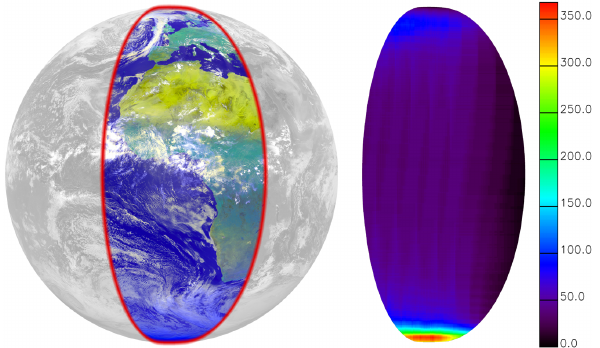
Fig. 6. Selected region for comparison between cirrus products (left panel). Numbers of synchronous observations from SEVIRI and MODIS in January 2008 (right panel).